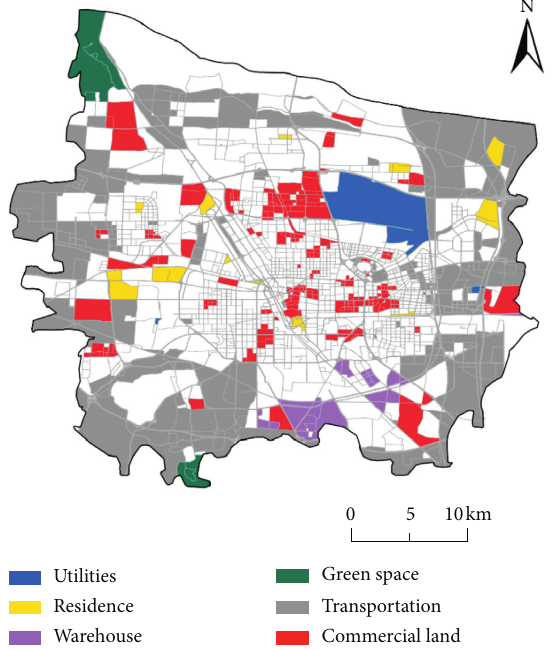
Figure 3: The single functional area map of Zhengzhou.